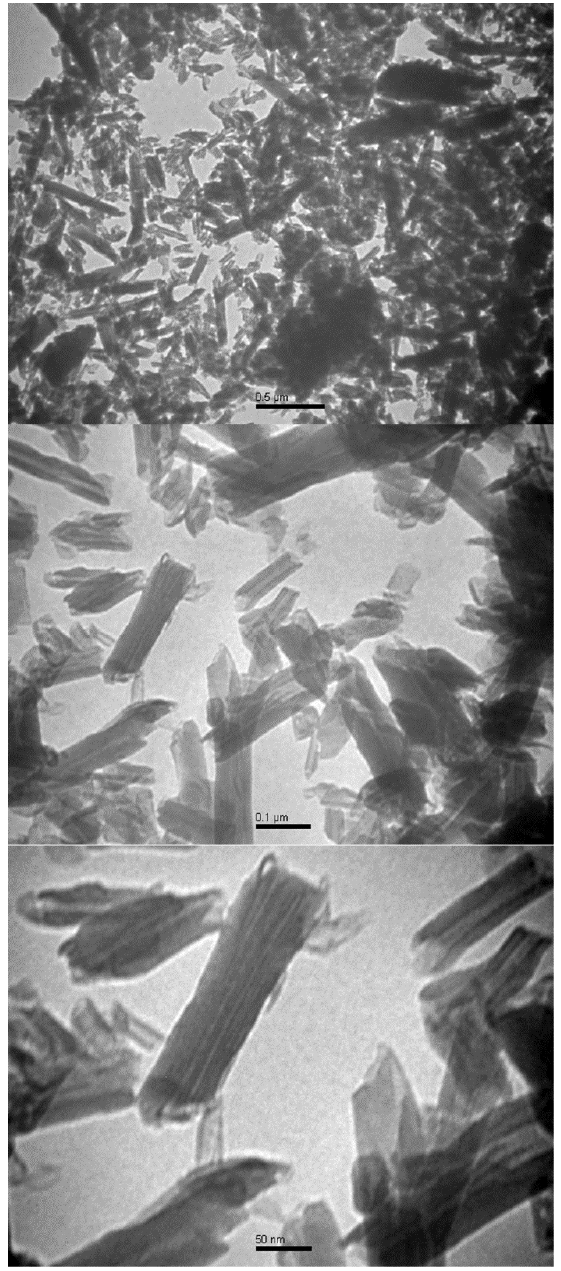
Figure 2. Transmission electron microscope (TEM) images of Halloysite nanoclay at different mag- nification powers.